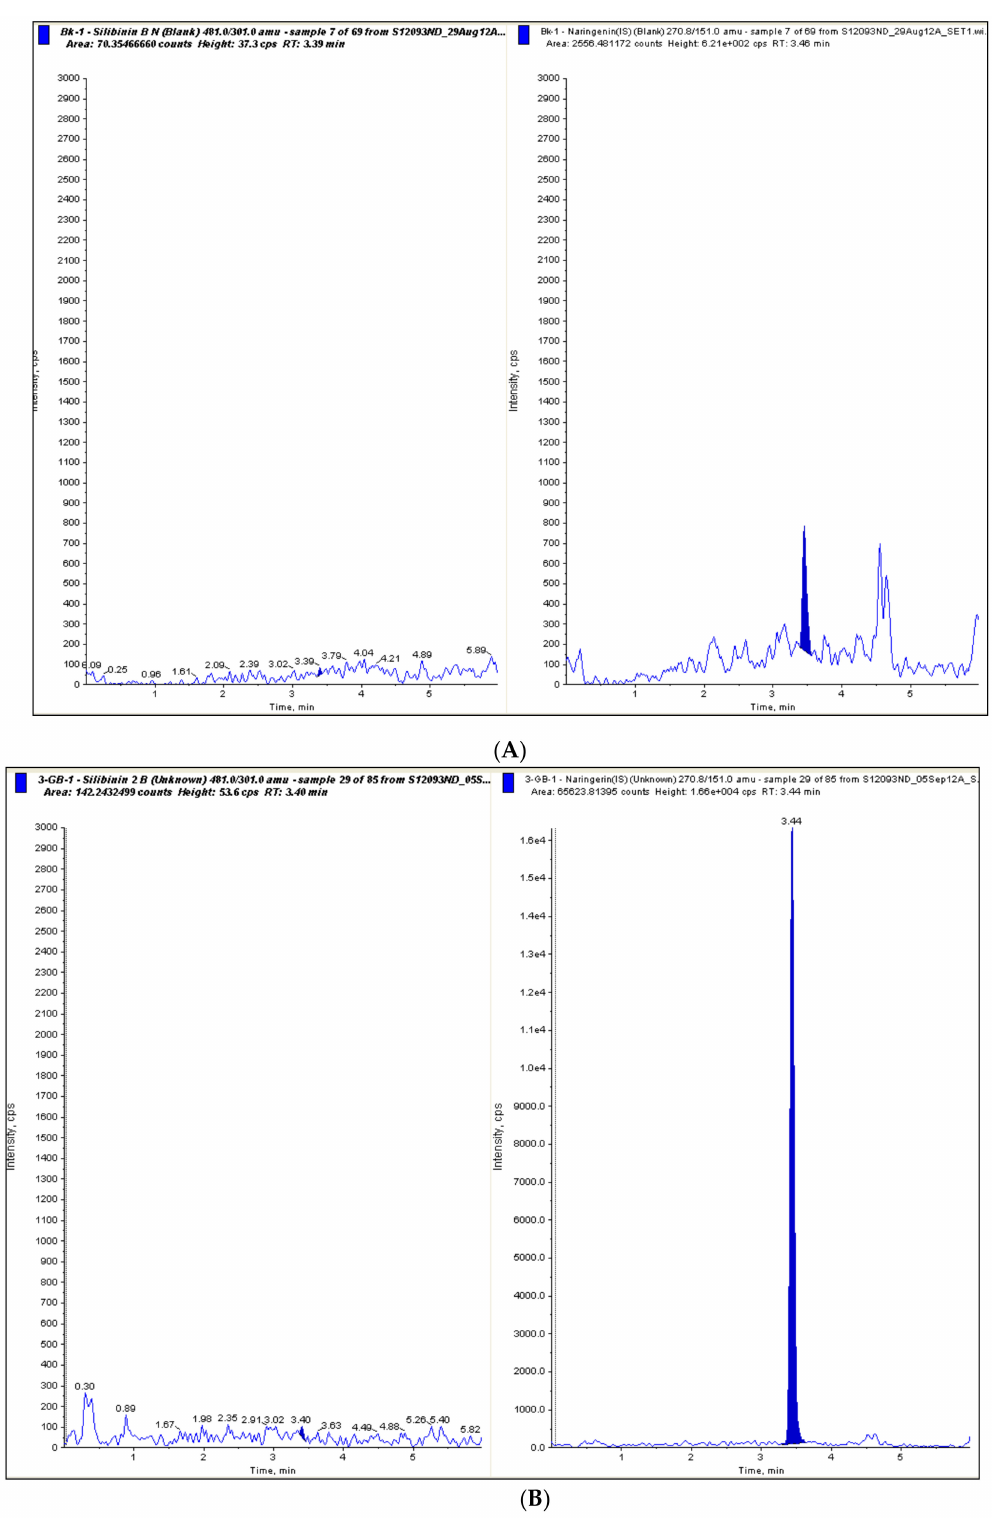
Figure 1. MRM chromatogram corresponding to a plasma blank sample without enzyme incubation ( A ) and a plasma blank sample incubated with β -glucuronidase from H. pomatia ( B ). In each panel: on the left, MRM chromatogram corresponding to silibinin; on the right, MRM chromatogram corresponding to the internal